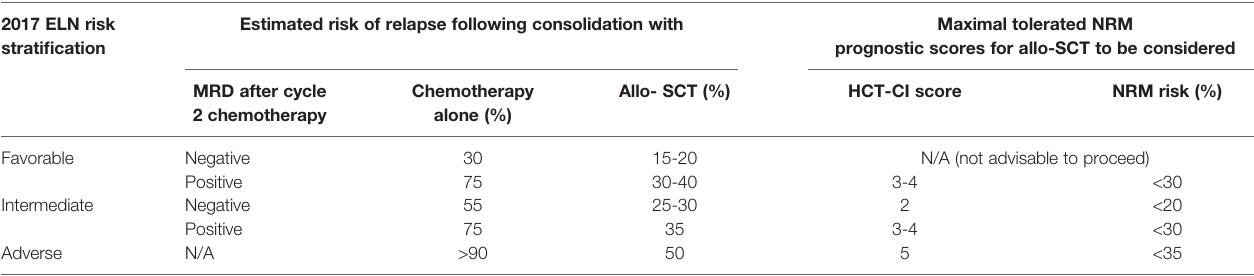
TABLE 1 | A table to demonstrate selection of patients for allogenic-SCT (Allo-SCT) with estimated relapse risk [Dohner et al. (5); Schuurhuis et al. (6)] with and without transplant and estimate of incidence of non-relapse mortality (NRM) following allo-SCT [Sorror et al.